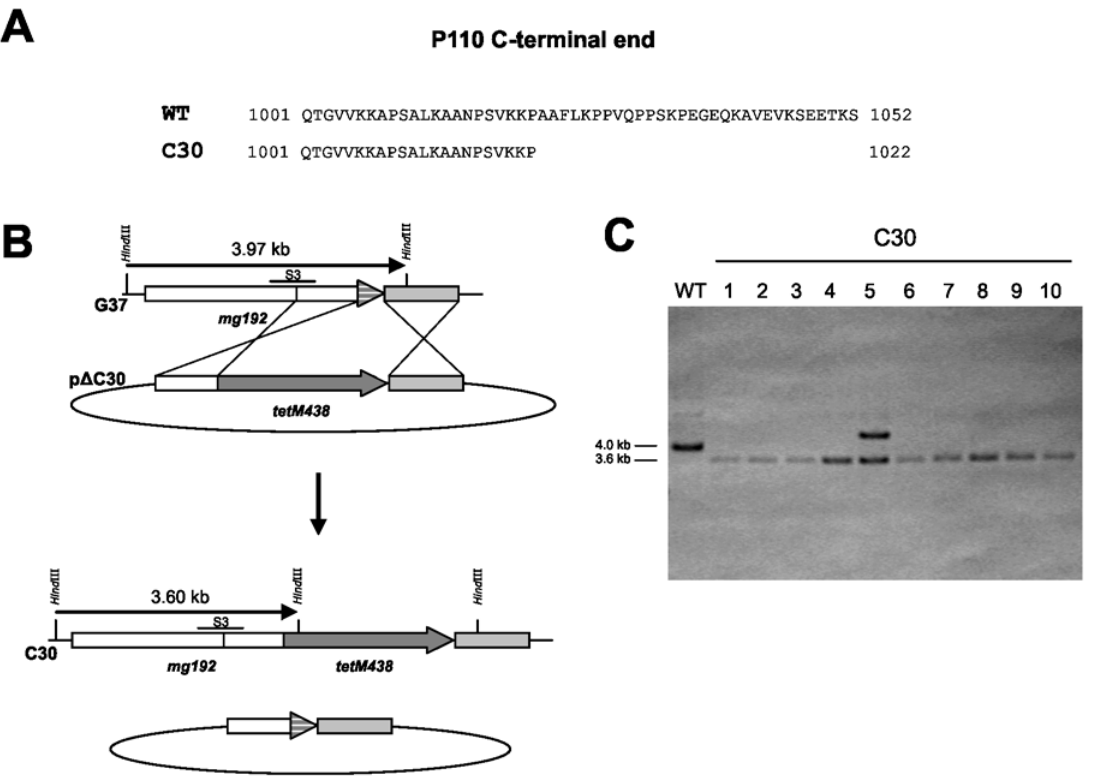
Figure 8. Construction of a M.genitalium mutant lacking the last 30 amino acids of P110. (A) Amino acid sequence of the P110 C-terminal end in the WT strain and the C30 mutant. (B) Schematic representation of the construction of the C30 mutant by homologous recombination using plasmid p D C30. (C) Southern blot analysis of the C30 mutants using the fragment S3 as a probe. Detection of a single band of about 3.6 kb in nine of the transformants is consistent with the intended deletion in the mg192 gene. Detection of two bands in the lane corresponding to clone 5 indicates the insertion of plasmid p D C30 in the genome of this transformant by a single crossover. This mutant was not considered for further analysis.